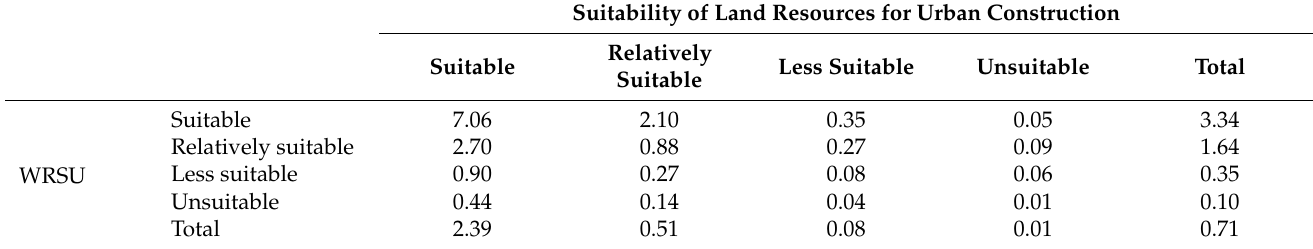
Table 6. Constructed land density under different water and land resources suitability grades